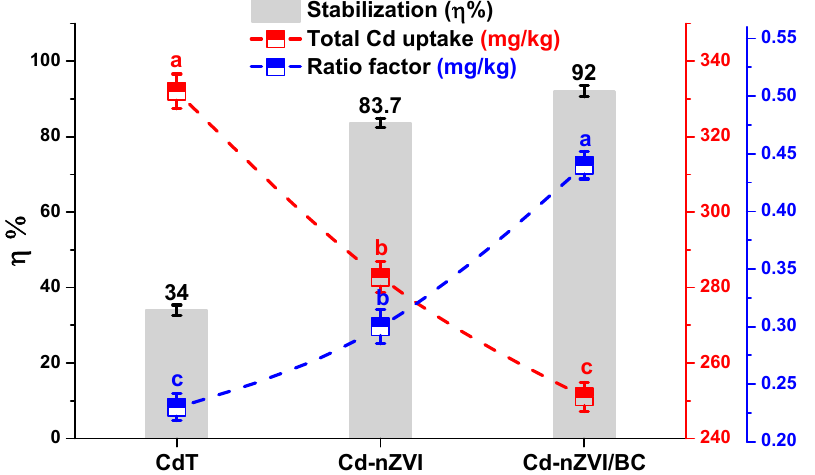
Figure 7. Impact of nZVI and nZVI/BC application in Cd stabilization performance, Total Cd uptake, and Root/shoot ratio factor. Bars not sharing the same lower-case letter are significantly different (Tukey’s HSD α < 0.05). Represented data are the mean ( n = 6) with ± standard deviation. Table 5. Impact of nZVI and nZVI/BC application on Cd uptake and immobilization.